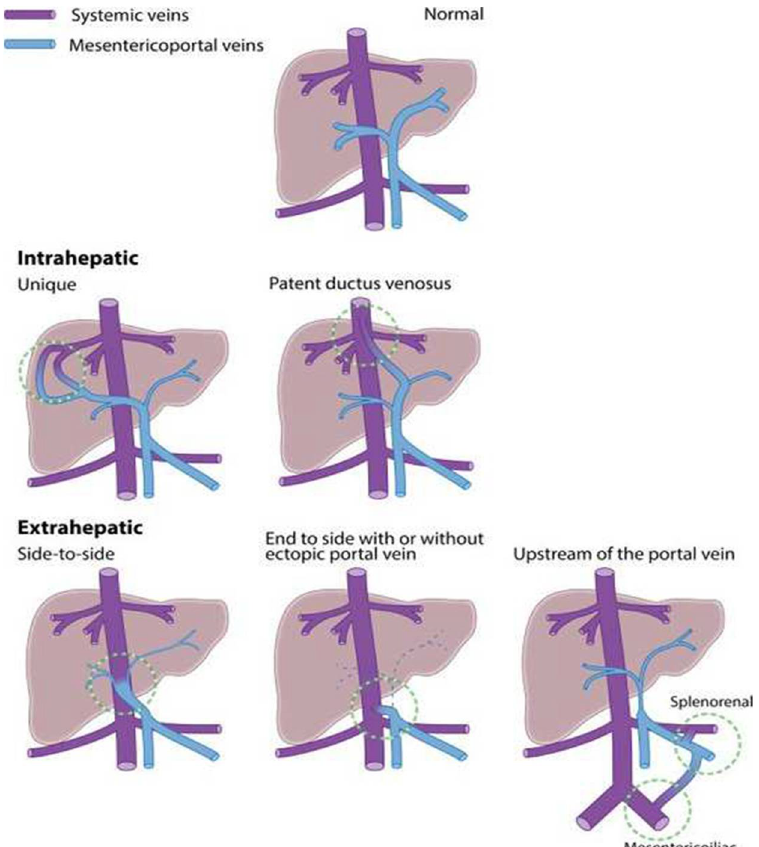
Figure 1. Anatomical forms of congenital portosystemic shunts. Reproduced from Guérin et al. Congenital portosystemic shunts: Vascular liver diseases: Position papers from the francophone network for vascular liver diseases, the French Association for the Study of the Liver (AFEF), and ERN-rare liver. Clin. Res. Hepatol. Gastroenterol. 452–459. Copyright © 2022 Elsevier Masson SAS. All rights reserved